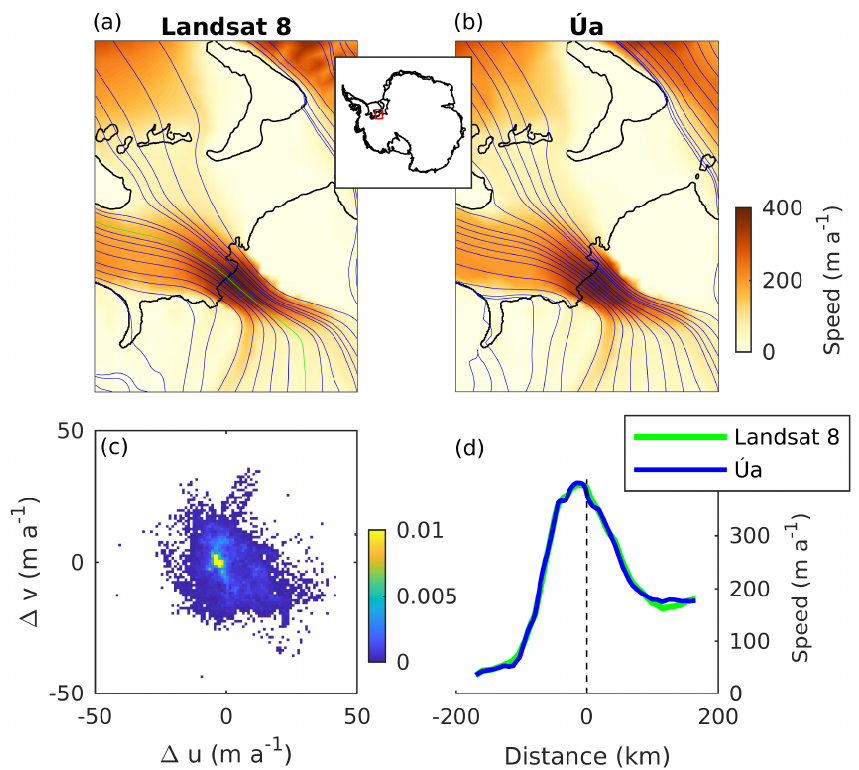
Figure 1. Observed ( a ; Gardner et al., 2018) and modelled (b) ice speed in the region of Institute Ice Stream. The inset displays the location of the plotted area in Antarctica. Grounding lines are shown as black lines and streamlines are displayed in blue. Panel (c) shows a normalised bivariate histogram of the velocity residuals which are the differences between modelled and observed velocities within this area, that is, (cid:49)u = u modelled − u observed and (cid:49)v = v modelled − v observed , and u and v are the horizontal components of the surface velocity vector, respectively. Panel (d) shows an ice-speed profile along the central line of Institute Ice Stream that is indicated in green in (a)